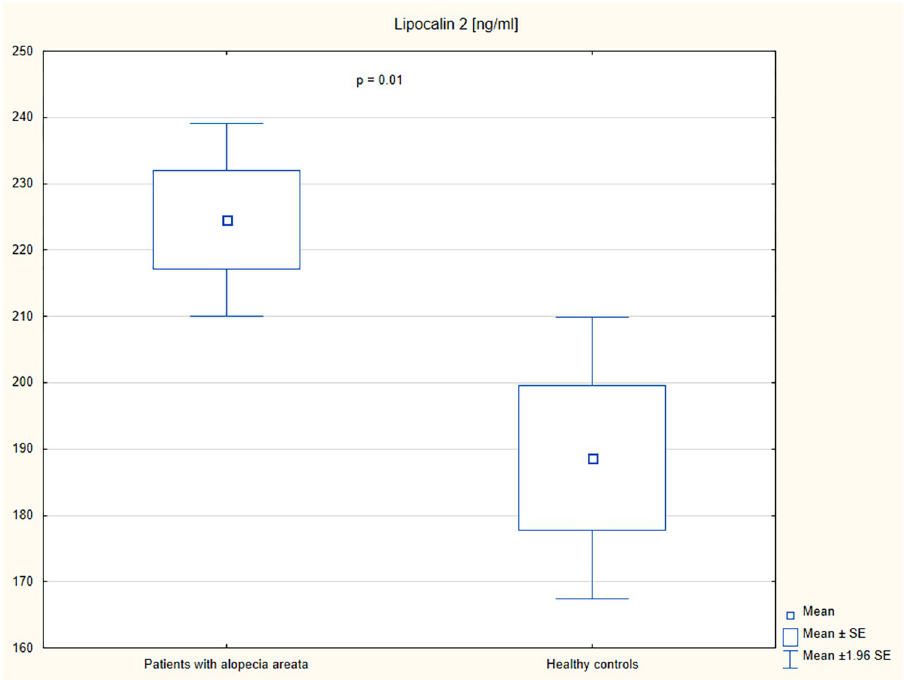
Fig 1. Serum concentrations of lipocalin-2 in patients with alopecia areata and healthy controls.